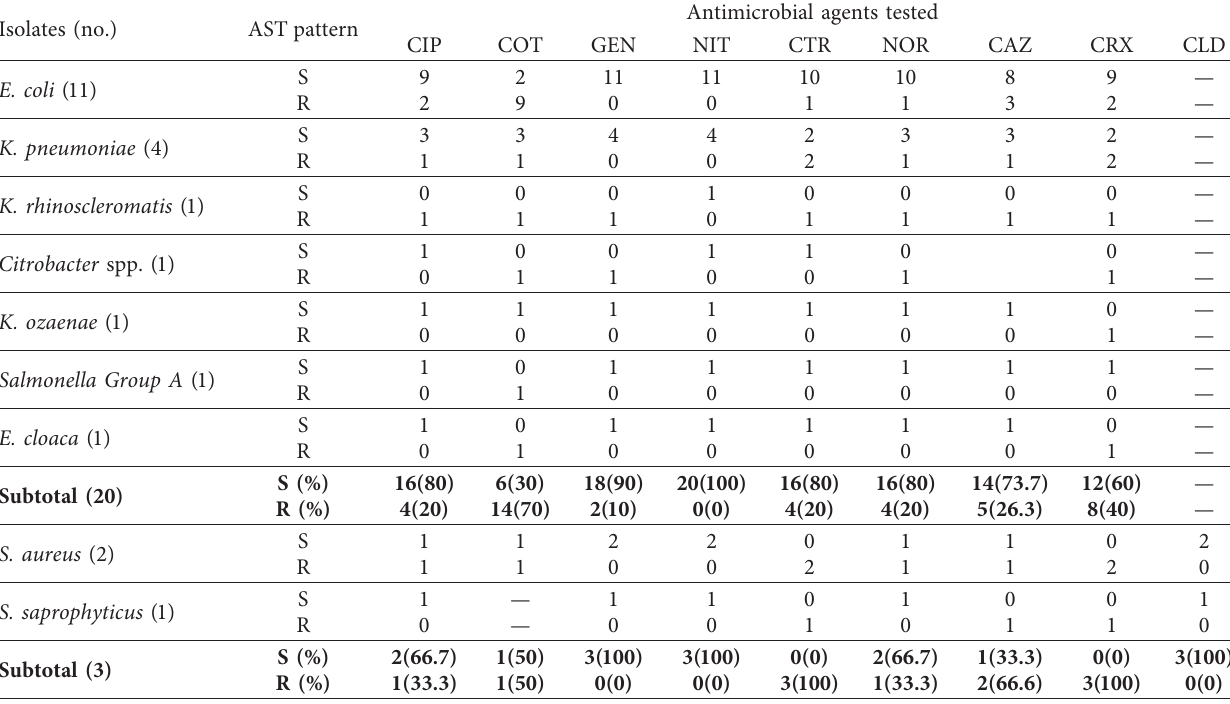
Table 2: Antimicrobial susceptibility pattern of gram-negative and positive bacteria isolated from urine culture of pregnant women attending ANC at HUCSH (as shown in Table 1) ( n � 23). Isolates